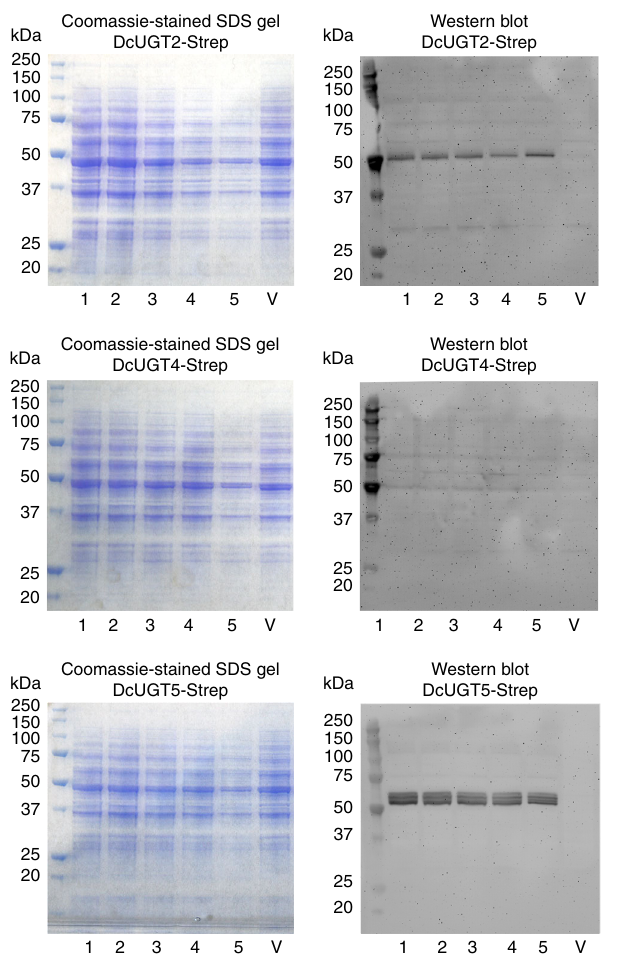
Fig. 3 Heterologous expression DcUGT candidates in yeast. Five individual S. cerevisiae transformants were cultured for each Strep-tagged UGT candidate, DcUGT2-Strep , DcUGT4-Strep and DcUGT5-Strep along with a transformant carrying the pYES-DEST52 vector. After galactose-induced heterologous protein expression, microsomal proteins were isolated from each transformant and separated on an SDS gel followed by either Coomassie staining or western blotting using an anti-Strep antibody. V pYES-DEST52 vector. Note that the anti-strep antibody reacts with the marker protein bands